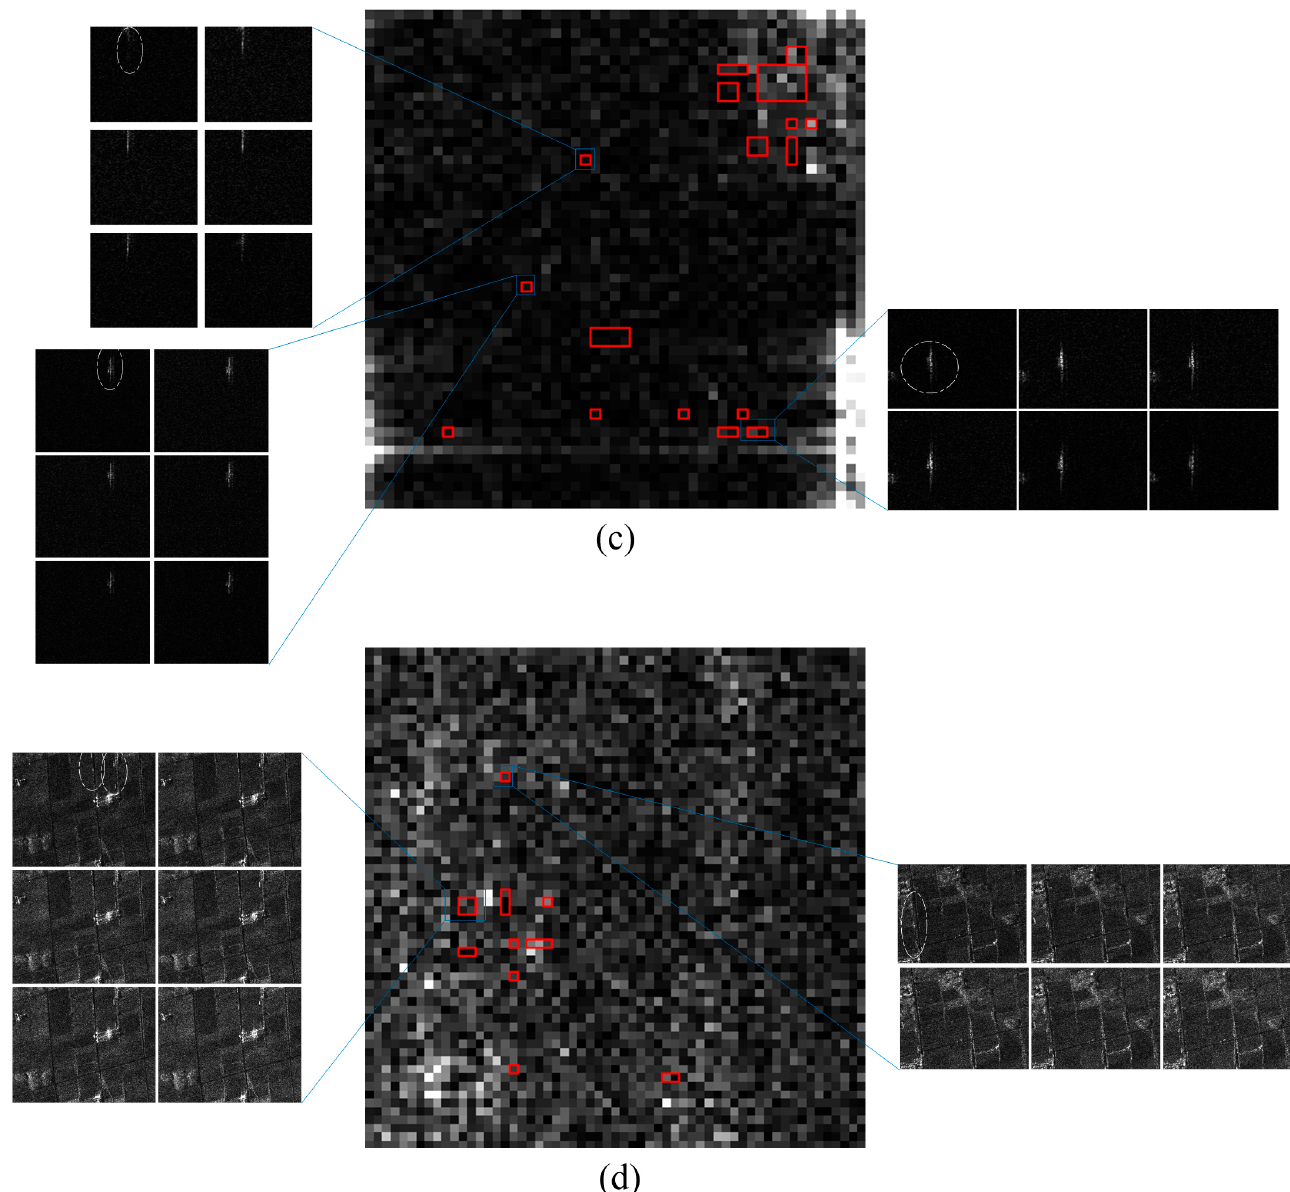
Figure 7. Detection results across four temporal sequences: the images in the middle are abstracted from the first low-resolution images that are obtained. ( a ) Ocean landscaped in Lvshungang. ( b ) Agricultural areas in Dingxin. ( c ) Ocean landscaped in Sasebo. ( d ) Agricultural areas in Jinmen. The red squares represent the areas wherein moving targets may exist. By calculating the geometric mappings and searching the high resolution, six subaperture decomposed Scheme 100. pixels in each direction, due to possible Doppler centroid mismatch), have been visually found and are indicated by the blue squares. The potential moving targets are encircled in white with these 11 groups of high-resolution sequential images on both sides, and the temporal lines are from left to right and top to bottom.